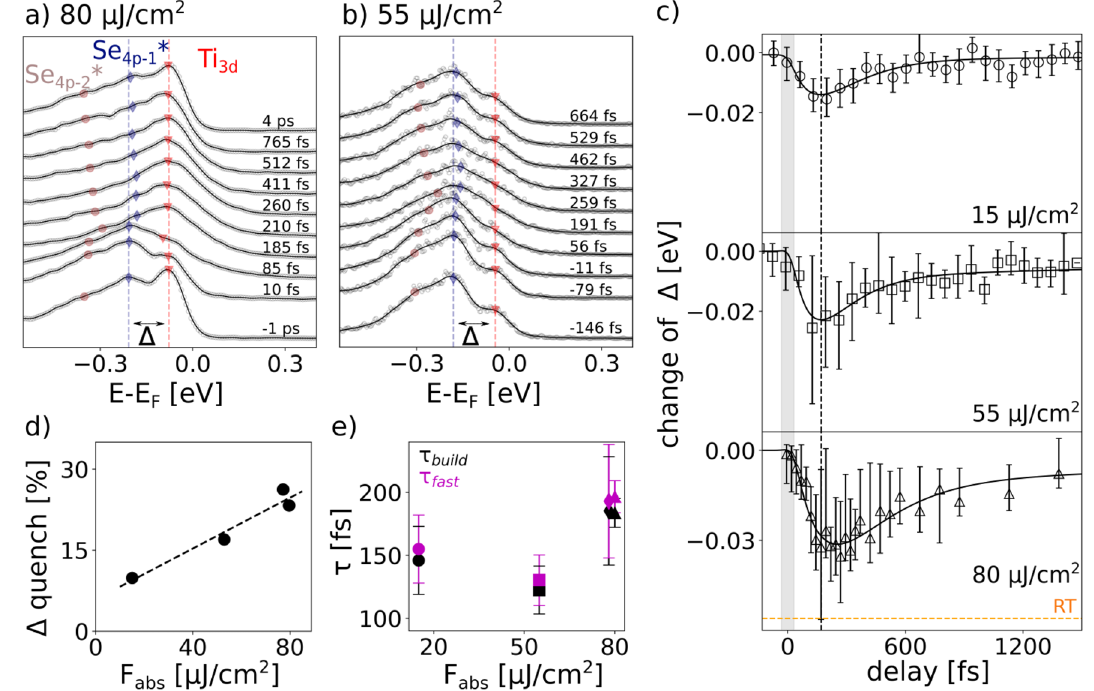
Figure 2. Gap dynamics at different excitation density. ( a , b ) Selected EDCs taken at M point with markers indicating the fitted peak positions of the Ti 3 d conduction band (red triangle) and the Se 4 p − 1 (blue diamonds) and Se 4 p − 2 valence bands (brown circles) after excitation with 80 ( a ) and 55 µ J/ cm represents raw data and solid black lines represent the smoothed raw data using the Gaussian method (10 meV window). ( c ) Fitted change of gap size over delay after excitation with 15, 55 and 80 µ J/ cm represent fits to the data. The dotted orange line represents the gap size extracted by equilibrium ARPES at room temperature 22 . ( d ) Maximum gap quench (with respect to the equilibrium value) in dependence of absorbed fluence F abs . Dashed line is a linear fit of the data points. ( e ) Fitting parameters τ build and τ fast in dependence of the absorbed